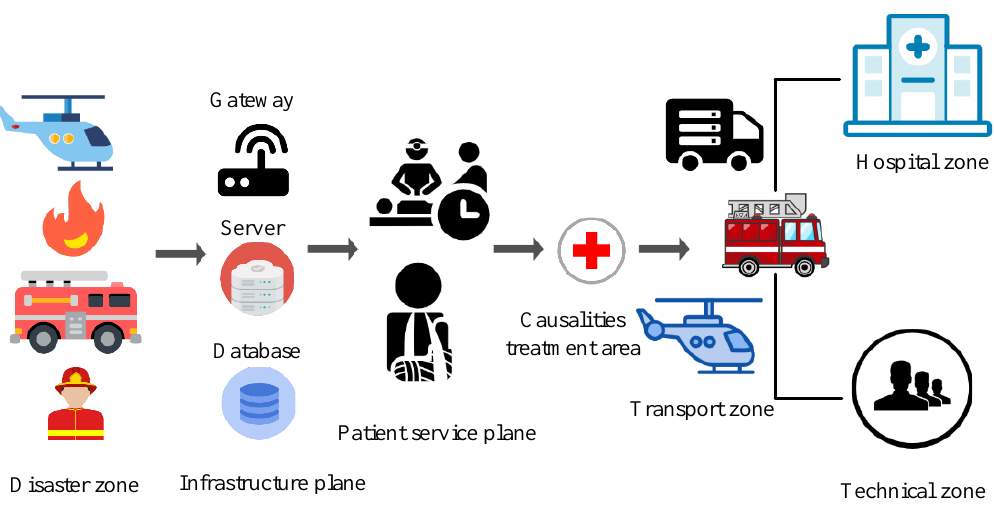
Figure 8. The architecture of IoT